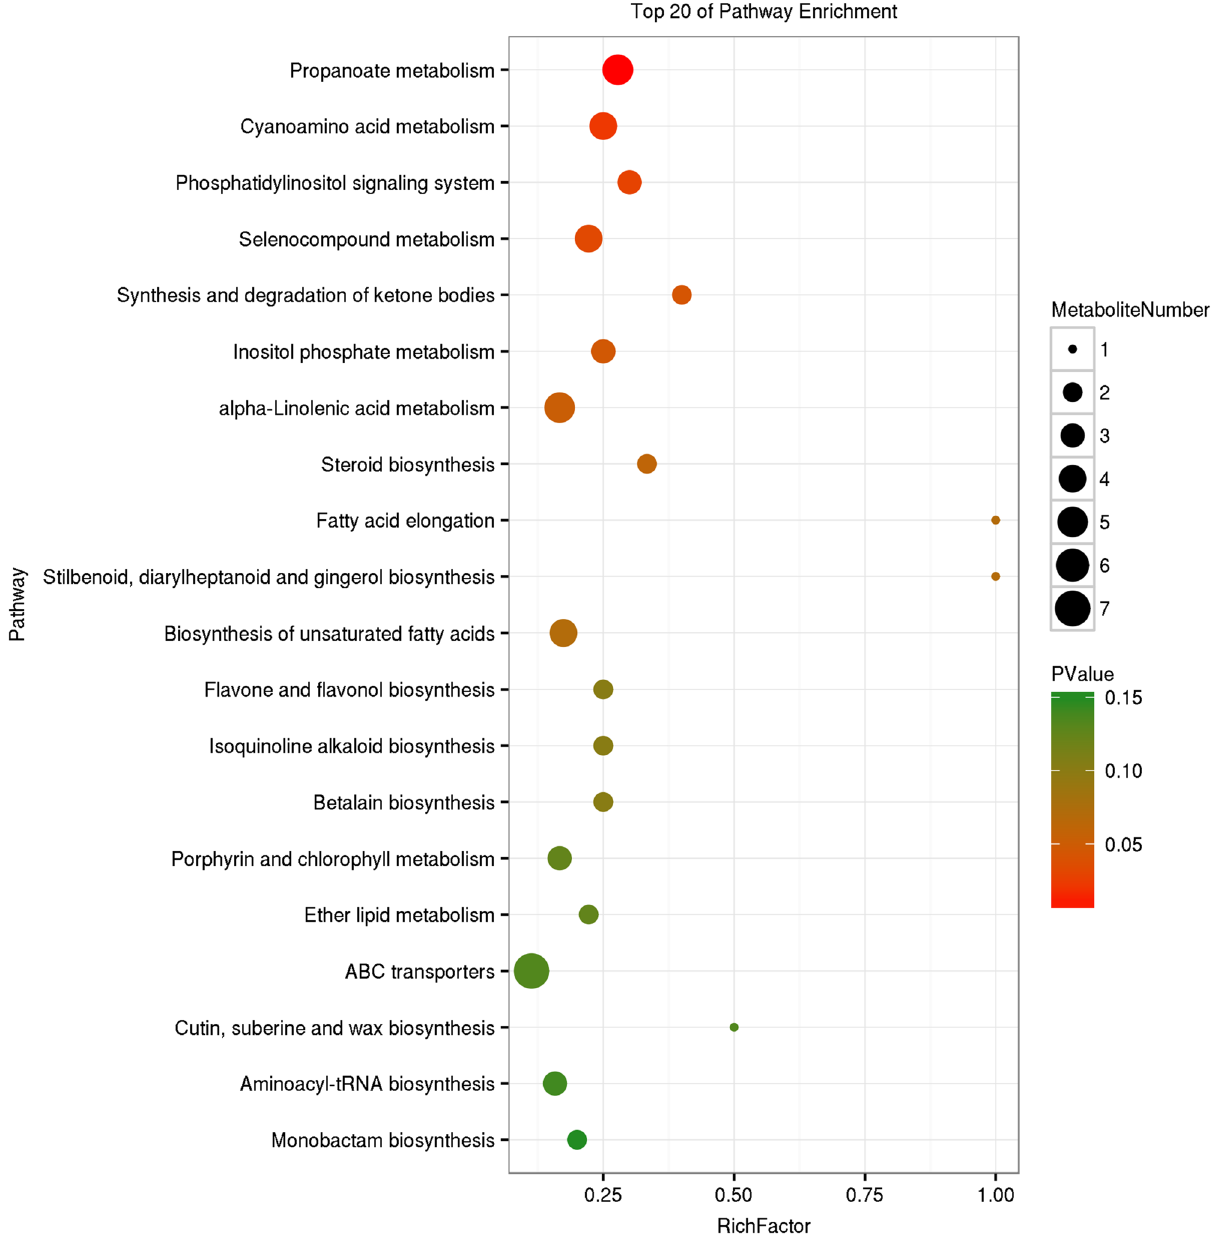
Figure 2. KEGG enrichment map of differential metabolites of two strains after 17 d culture. The vertical axis represents pathway entries, and Rich Factor on the horizontal axis refers to the ratio of the number of differential metabolites in the pathway to the total number of metabolites in the pathway. Higher Rich Factor values indicate a higher degree of enrichment. The size of the circle corresponds to the number of enriched metabolites, with a larger circle indicating more genes. P values range from 0 to 1, corresponding to the gradual change from red to green, with red being zero and indicating more significant enrichment. The figure is plotted with the first 20 pathways of P values from smallest to